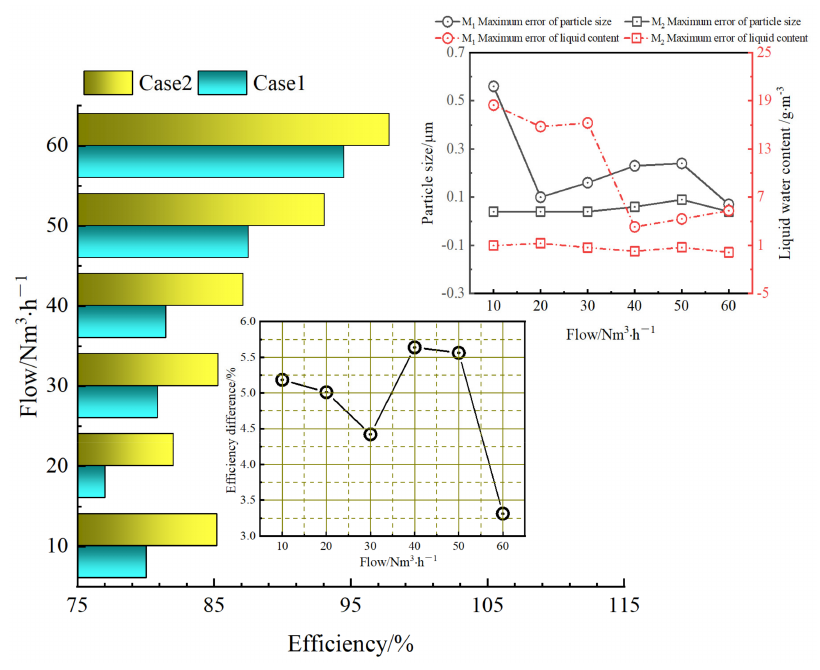
Figure 7. Comparison of separation effect between Cases 1 and 2.